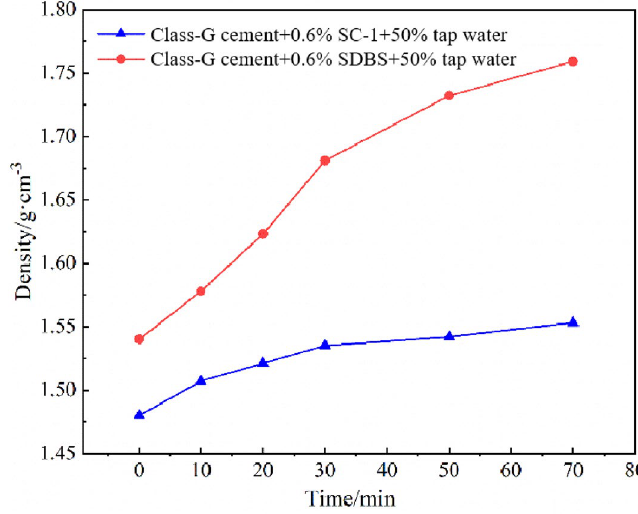
Figure 3. Variation of density of foamed cement slurry with time.